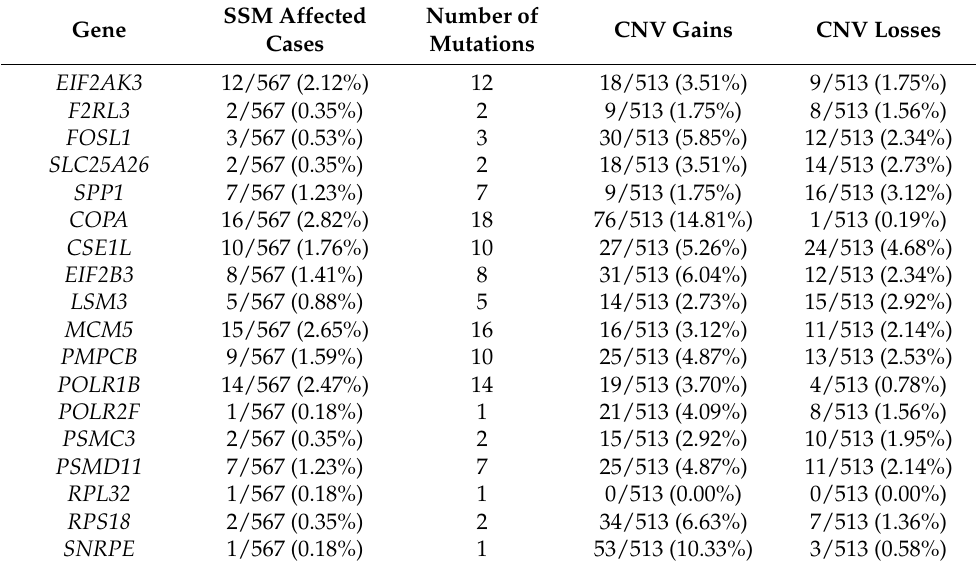
Table A1. The number of patient cases affected by CNV and mutation of the identified genes in TCGA-LUAD.